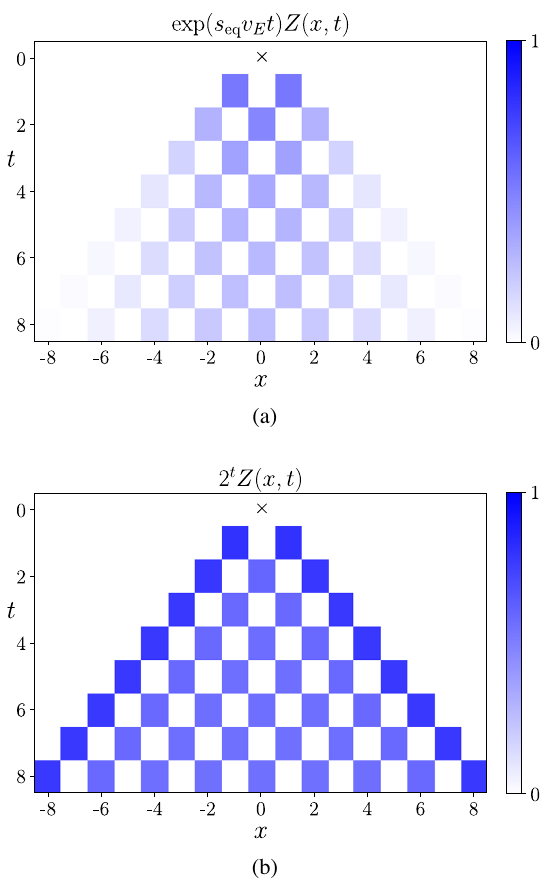
˜ Z FIG. 12. Heat map of ð x; t Þ ¼ exp ð s eq v E t Þ Z ð x; t Þ . (a) Floquet ˜ Z Ising model as in Fig. 8(a). ð x; t Þ is consistent with the solution of a parabolic equation. For example, the decay at x ¼ 0 is compatible with the t − 1 = 2 scaling in Eq. (83): This scaling is demonstrated in Appendix B 6. (b) Dual-unitary model as in ˜ Z Fig. 8(b). Unlike the previous model, ð x; t Þ is approximately constant in the interior of the light cone and zero